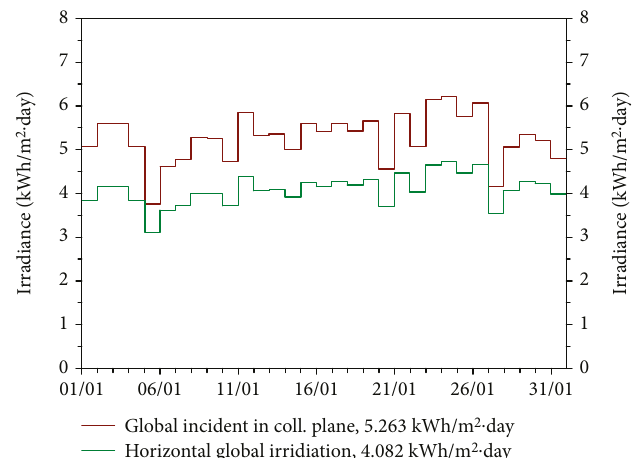
Figure 5: First month values of horizontal global irradiation and global incident in coll. plane.